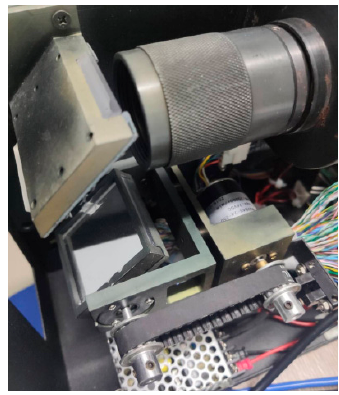
Figure 5. A physical figure diagram of the rotating mirror.